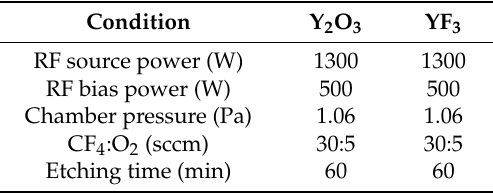
Table 2. Plasma etching parameters for Y 2 O 3 and YF 3